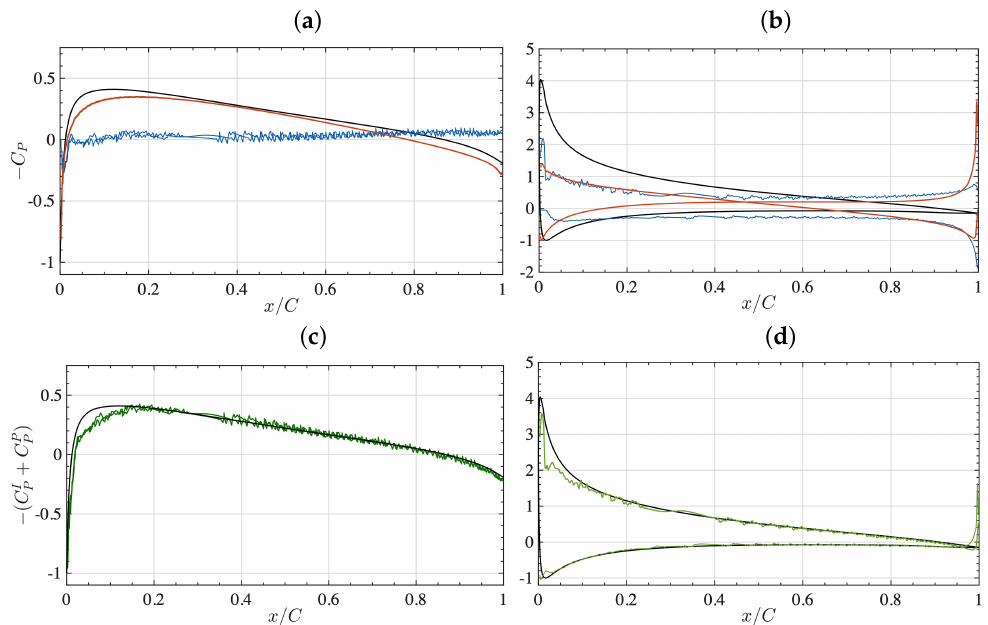
Figure 10. Pressure coefficients (plotted as − C p ) along the NACA-0012 foil upper and lower boundaries, calculated with the pLBM-LES model for Re = 1.44 × 10 6 with a Grid 3 resolution ∆ x / C = 2.5 × 10 − 3 , at angles of attack: ( a , c ) θ = 0 ◦ , and ( b , d ) 8 ◦ , compared to Xfoil results (—). ( a , b ) perturbation/inviscid components, C P